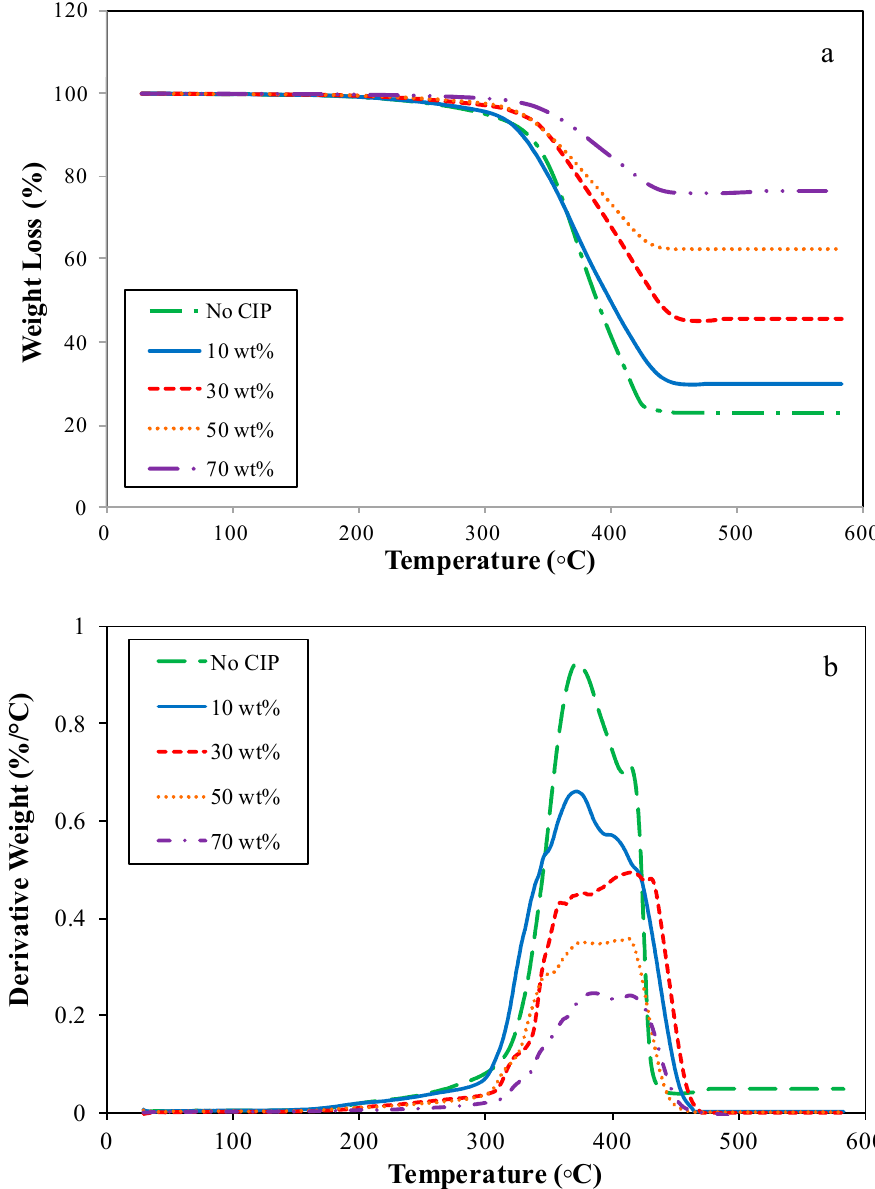
Figure 3. Thermal features of ENR-based MREs. ( a ) Thermogravimetric (TG) curves and ( b ) Differential thermal gravimetric (DTG) curves.